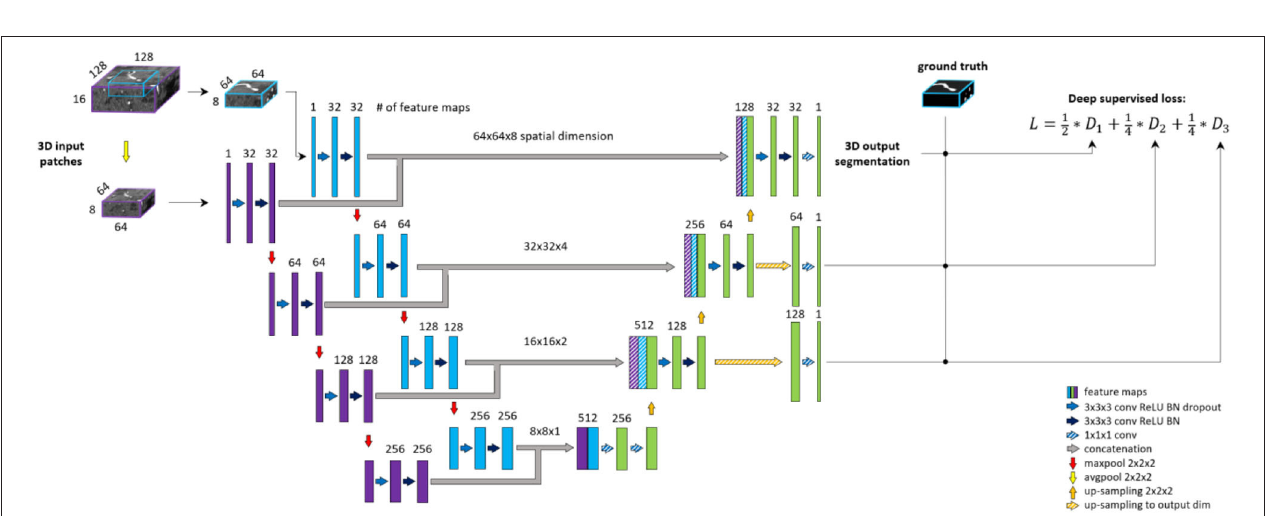
FIGURE 4 | BRAVE-NET architecture. The model is composed of a Unet architecture extended with context aggregation and deep supervision. Feature maps of intermediate decoding levels are up-sampled to output—spatial—dimension (striped yellow arrows) and prediction masks are produced by 1 × 1 × 1 convolution and sigmoid activation (striped blue